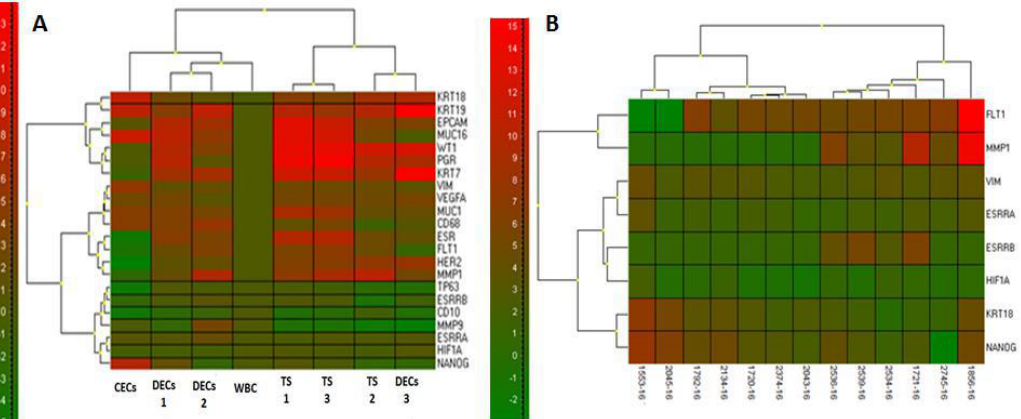
Figure 2. Relative RNA quantity for CECs and endometriosis tissue samples shown after cluster analysis. ( A ) Samples for one patient’s CEC tissue sample (TS) collection are presented with eight samples in total. Tissue samples TS 1–3 were obtained during surgery, as well as peritoneal washing (PW; a source for disseminated endometrial cells (DEC)). DEC 1 and DEC 2 were cultured after size-based filtration. DEC 3 was cultured without preliminary enrichment of PW. In the left subcluster, there are gene expression profiles of loose endometrial cells from the blood and DECs isolated by size-based separation. The second cluster is represented by endometriosis tissue biopsy samples TS 1, TS 2, and TS 3 and in vitro cultured PW. Two tissue samples (TS 1 and TS 3) are clustered together and show a very high level of similarity. For this patient with an endometriotic cyst, MUC16 was also detected on CECs. ( B ) Cluster analysis for high-positive CECs samples is shown. The analysis revealed that there were at least two different sample types of high-positive CECs (two clusters). The first one is represented by the cluster showing a high expression of FLT1 , MMP1 , and ESRRB (cluster on the right). The second group of samples shows elevation of NANOG , KRT18 , and VIM expression. KRT19 was relatively highly expressed in both clusters (not shown).